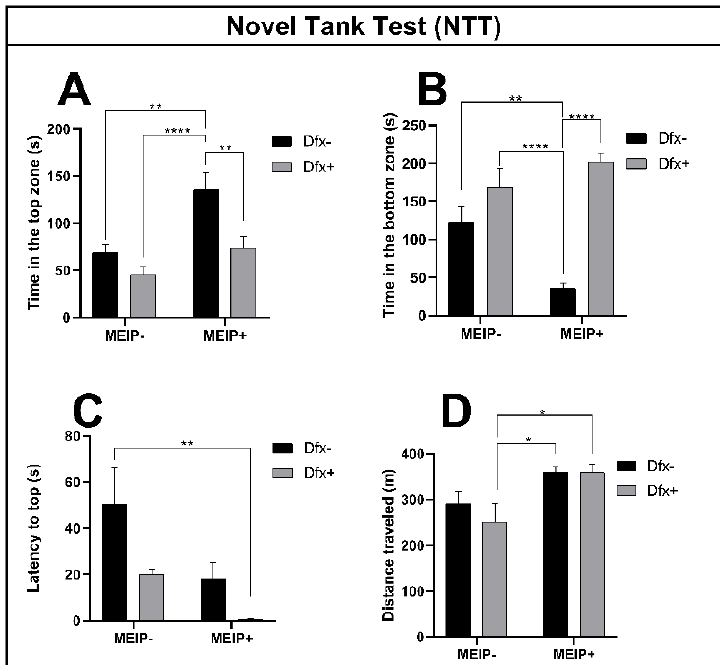
Figure 2. Novel Tank Test (NTT) in Zebrafish. Representation of the time in the top zone ( A ); time in the bottom zone ( B ); latency to top zone ( C ); distance traveled ( D ) of fish exposed to Dfx supplemented MEIP. Data are expressed by the mean ± SEM analyzed by ANOVA two-way with Tukey’s post-hoc test. * p < 0.05, ** p < 0.01 and **** p < 0.0001.